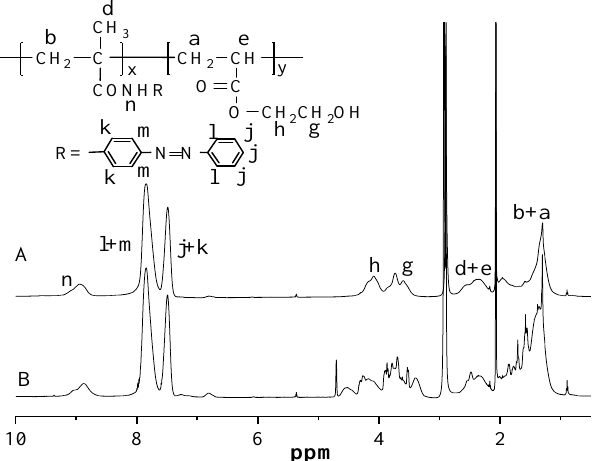
Figure 4. 1 H-NMR spectra of PMAAAB- ran -P(THP-HEA) (B) and PMAAAB- ran -PHEA (A).